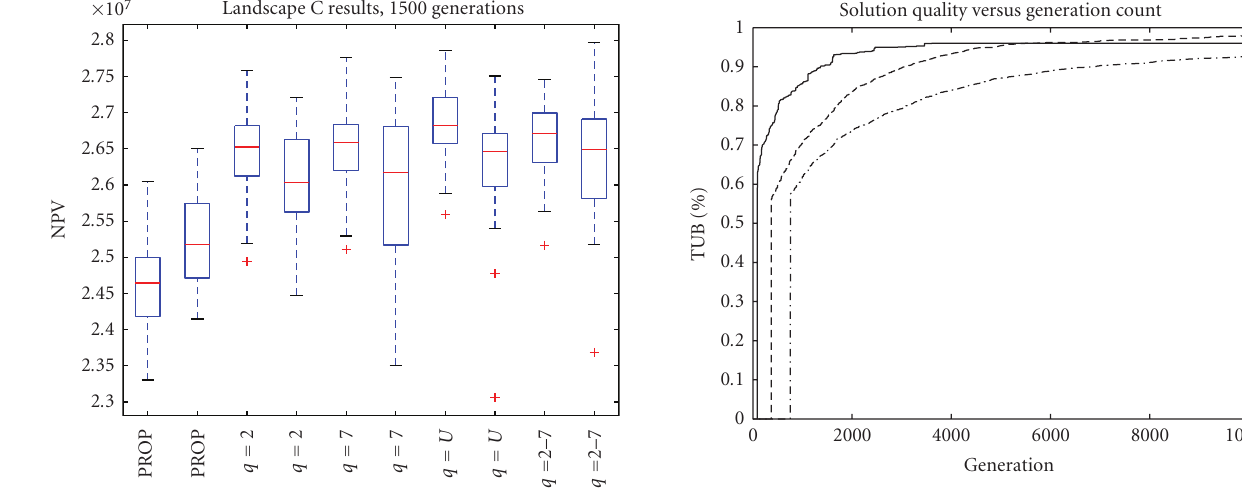
Figure 5: Results for Landscape C, 1500 generations. This figure presents a box-plot of solution quality (NPV; y -axis) for each paired selection/penalty strategy tested. The x -axis displays the strategy; static and dynamic penalty strategies for the same selection strategy are displayed side by side (static on the left side). Reading from left to right, the first selection strategy presented is proportional selection and the rest are deterministic tournaments with various competitor pool sizes ( q ). The label “ q = U ” corresponds to the strategy wherein q was sampled from a uniform distribution over the range (2, 10), and the label “ q = 2–7” corresponds to the strategy where q increased from 2 to 7 during the search.